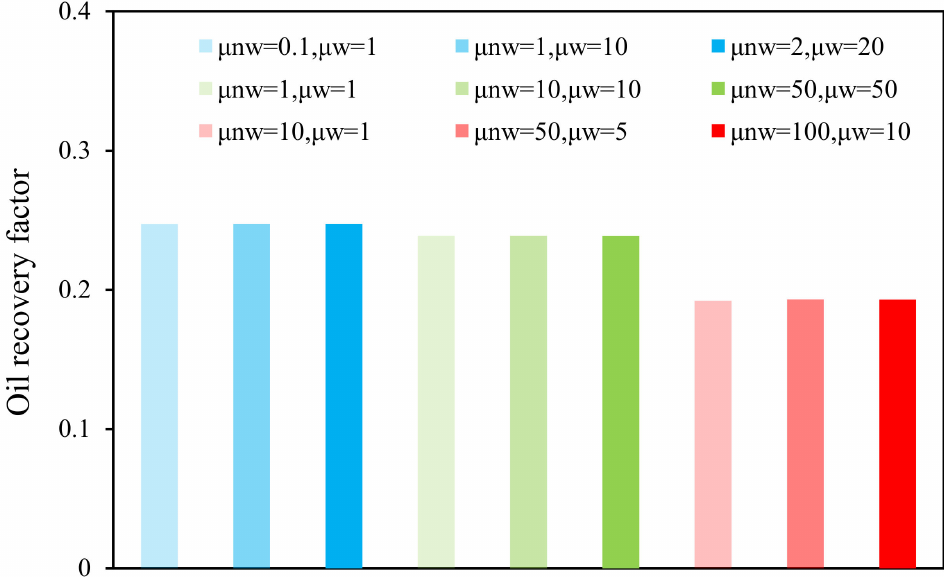
Figure 13. Oil recovery factor under different viscosity ratios (M = µ nw / µ w is 0.1 (blue), 1 (green), 10